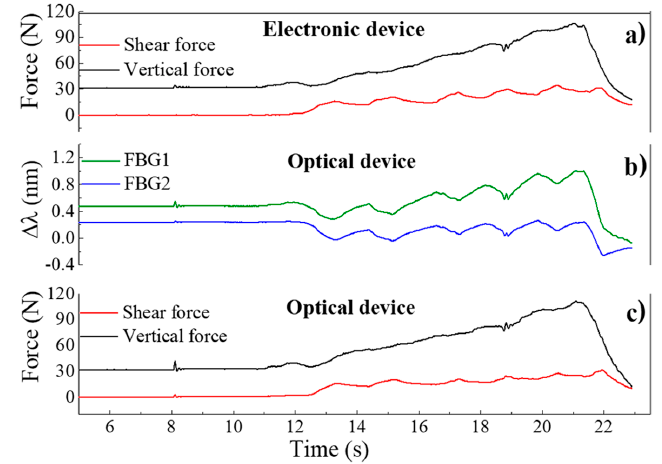
Figure 6. Response to the applied forces as a function of time for the: ( a ) electronic sensor; ( b ) FBGs cell, with the response as Bragg wavelength shift; ( c ) FBGs cell, the forces are calculated by applying Equation (2) to the registered wavelength shifts.